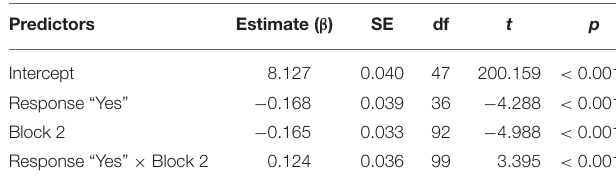
TABLE 3 | Overview of the model comparing the response times of the pragmatic and literal interpretations, with reference levels: Response: “No,” and Block: